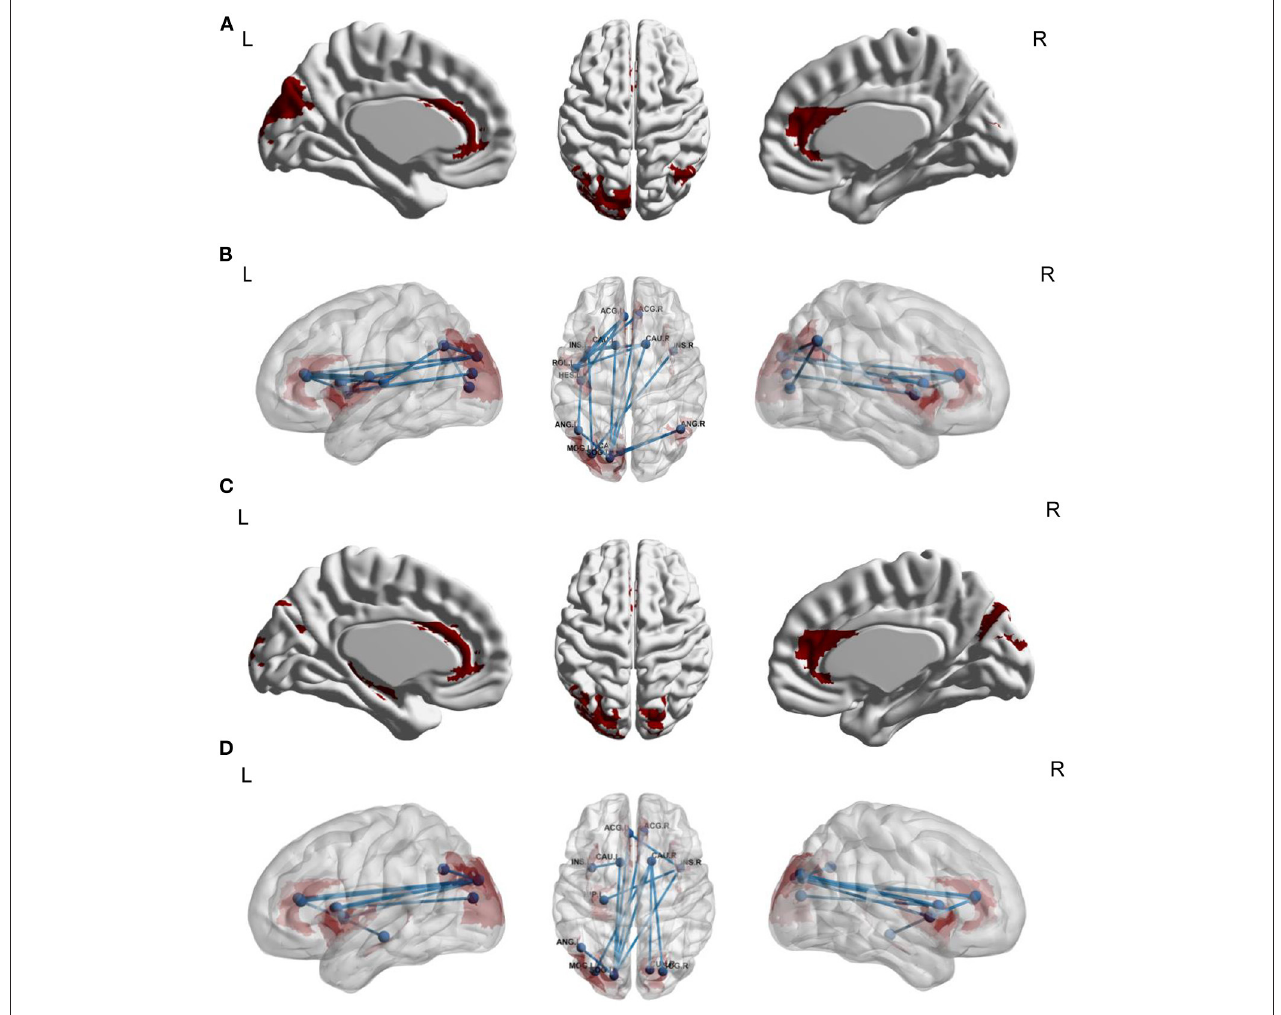
FIGURE 2 | Functional connectivity links associated with stereotyped behaviors (A,B) and overall RRBIs (C,D) ( n = 147). (A,B) Network-based statistic results for stereotyped behaviors in ASD patients. The underlying functional network included 17 edges between 13 brain regions. (C,D) Network-based statistic results for overall RRBIs. The correlated connectivity network included 12 edges between 12 brain regions. In the NBS analysis, we adjusted several covariates, including sex, age, FIQ, eye-status during scan, and medication status. ACG_L, left anterior cingulate gyrus; ACG_R, right anterior cingulated gyrus; CAU_L, left caudate; CAU_R, right caudate; INS_L, left insular; INS_R, right insular; ROL_L, left rolandic operculum; HES_L, left heschl’s gyrus; ANG_L, left angular; ANG_R, right angular; MOG_L, left middle occipital gyrus; SOG_L, left superior occipital gyrus; CAL_L, left calcarine; ACG_L, left anterior cingulate gyrus; ACG_R, right anterior cingulate gyrus; HIP_L, left hippocampus; CUN_R, right cuneus; SOG_R, right superior occipital